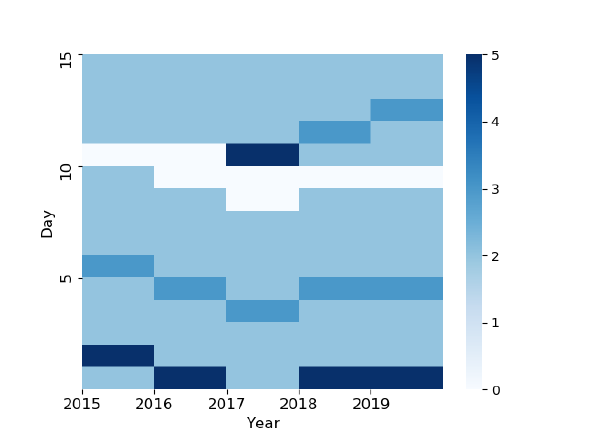
Figure 14: Clustering output for O 3 for first 15 days in Q 1 over 2015 to 2019.